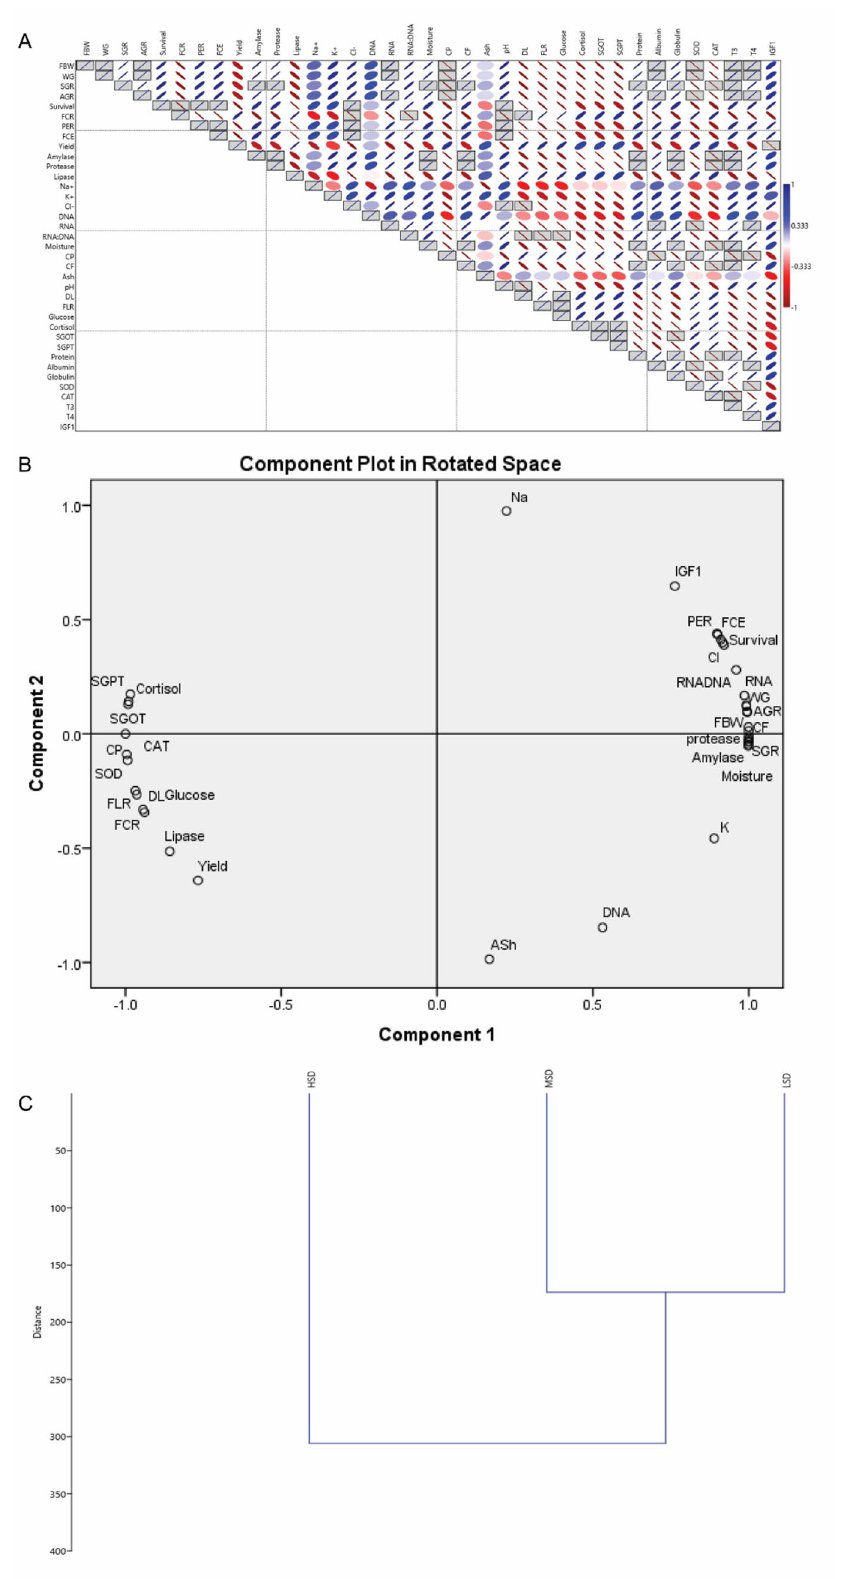
Figure 2. ( A ) *Pearson correlation coefficient, ( B ) **Principal component analysis, and ( C ) ***Hierarchical cluster analysis using growth attributes and multiple biomarkers of L. rohita cultured in three stocking densities in cages. *Red coloured small eclipse showed negatively correlated variables while blue coloured small eclipse shape showed positively correlated variables, large eclipse showed less correlated variables, boxed variables showing significantly ( P < 0.05) correlated. **Extraction method: Principal component analysis, Rotation method: Varimax with Kaiser Normalization, ***Wards method with Euclidean